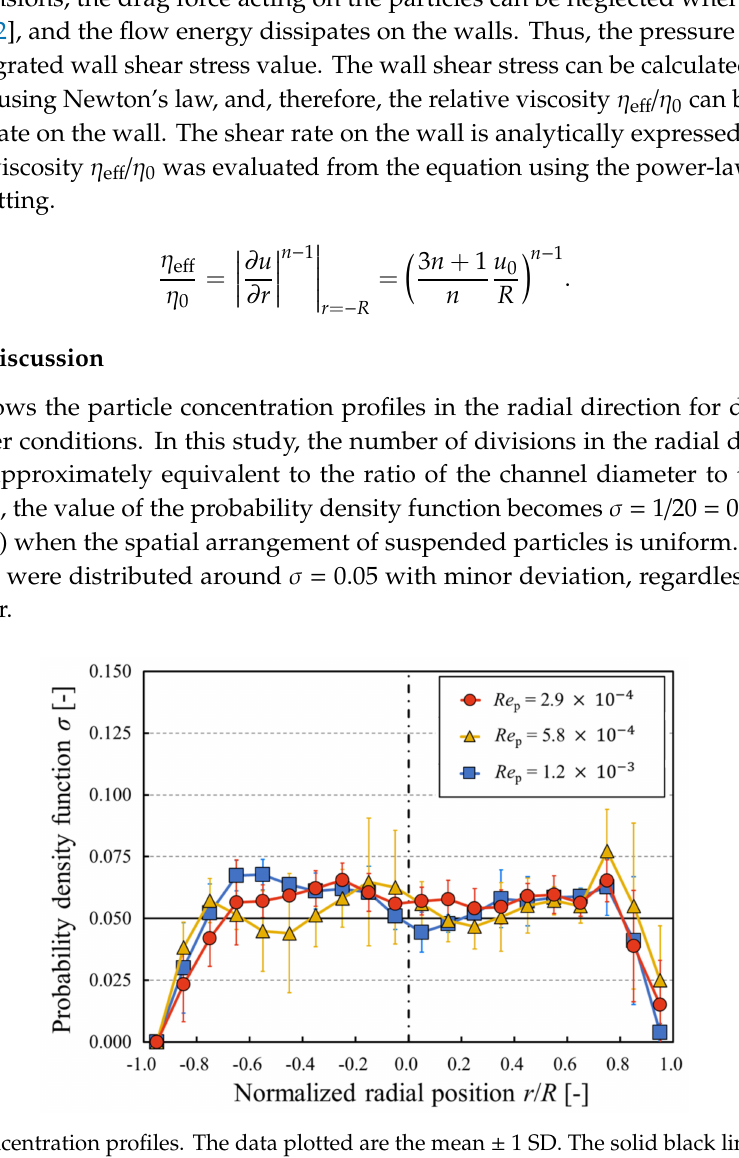
Figure 4. Concentration profiles. The data plotted are the mean ± 1 SD. The solid black line represents uniform distribution, and the black dash–dot line at r / R = 0.0 indicates the center of the